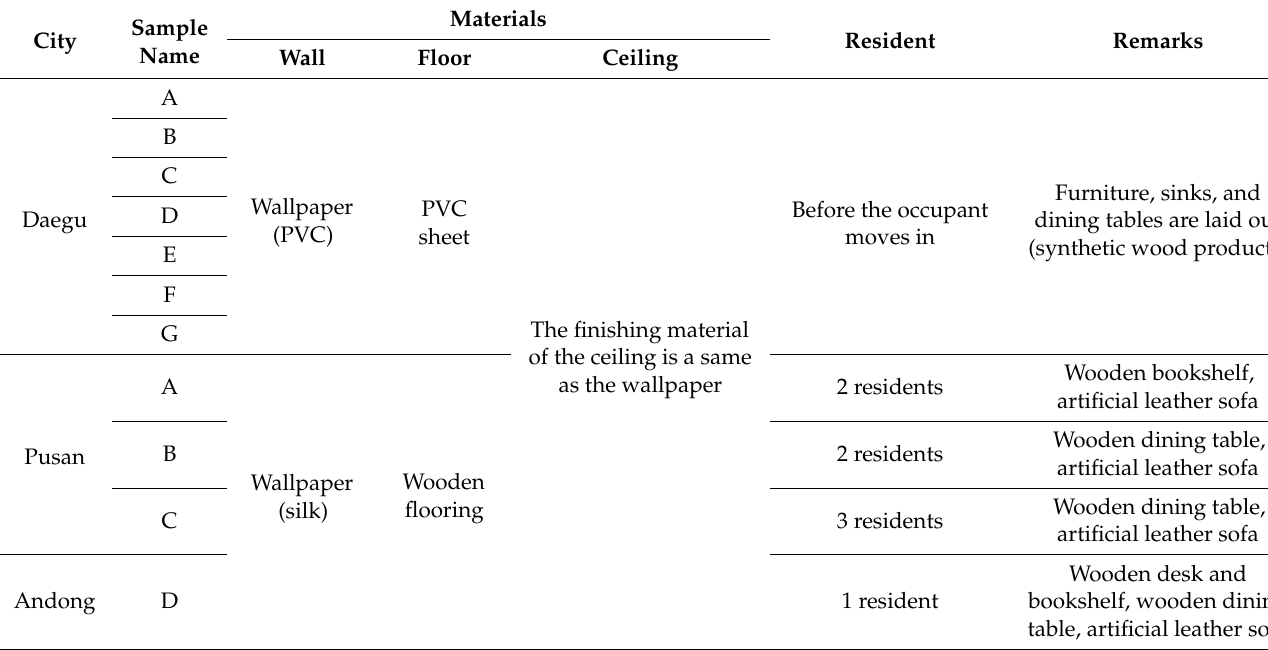
Table 2. Finishing materials and singularities in the house.